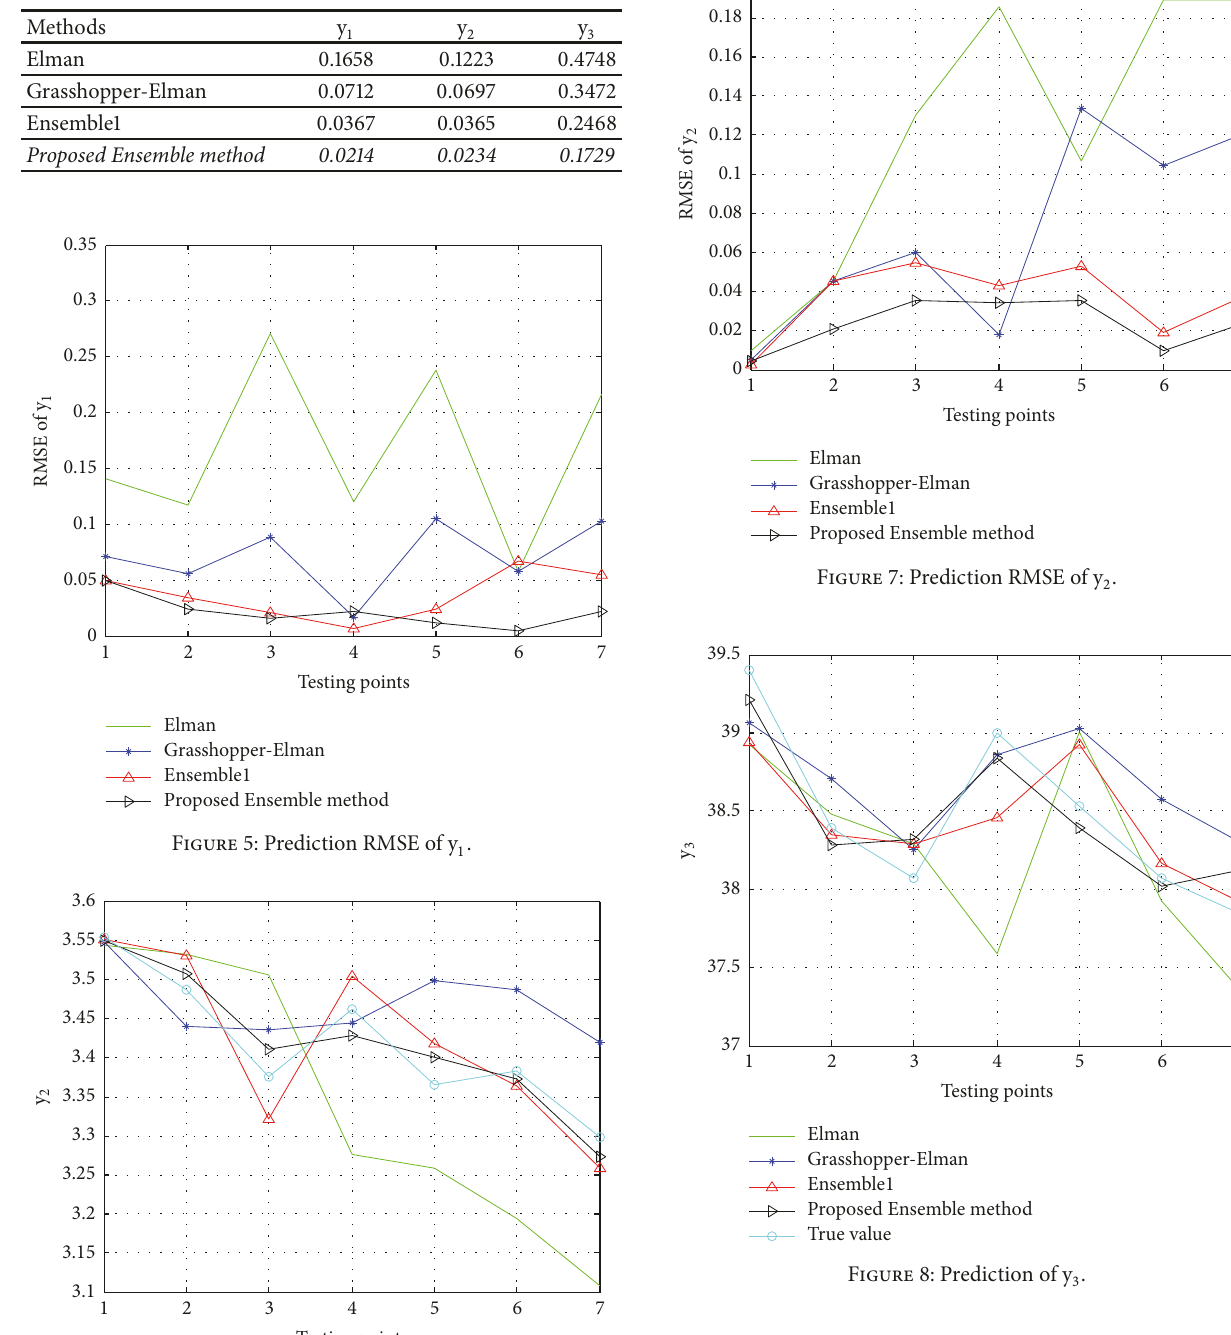
Table 2: Average prediction RMSE.